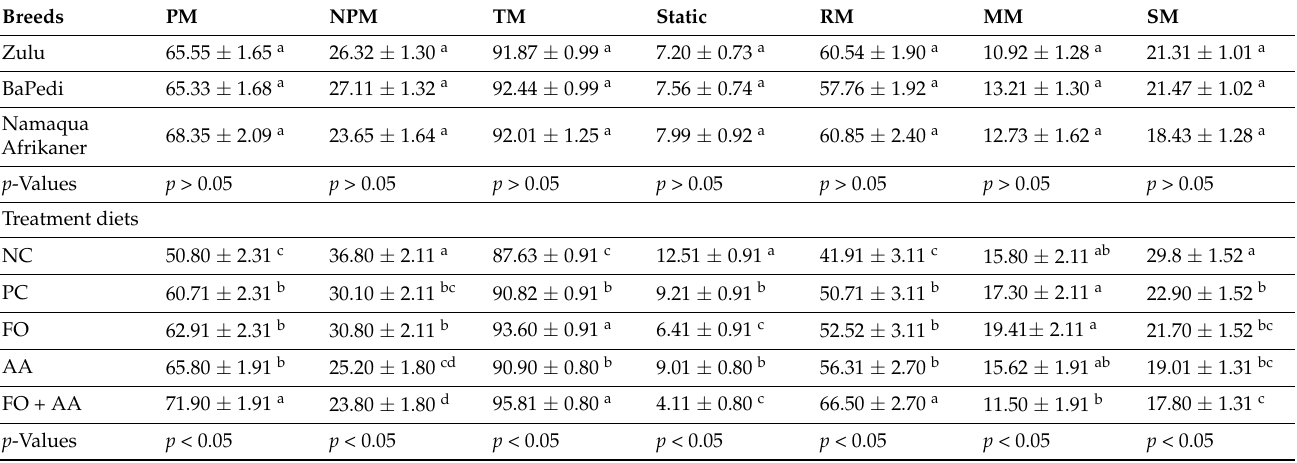
Table 4. Influence of breed and dietary flaxseed oil and ascorbic acid on sperm motility